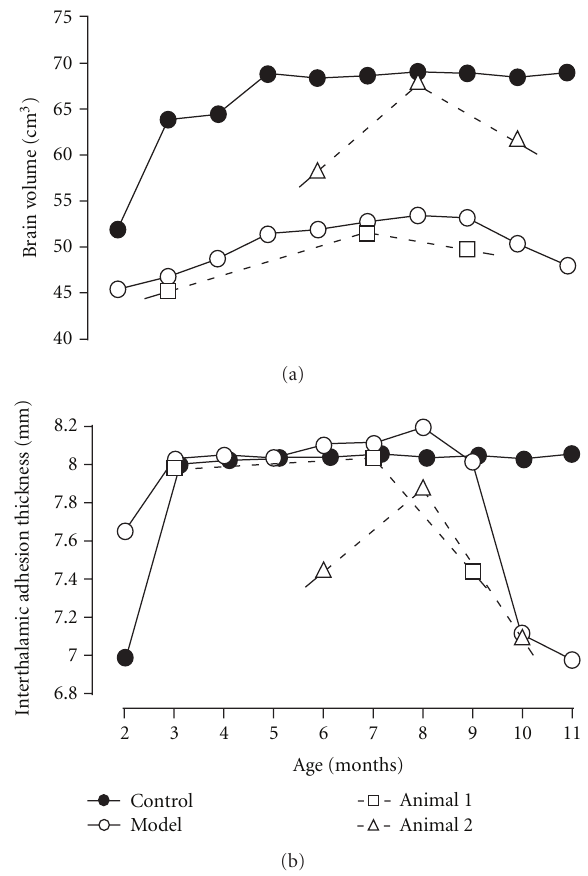
Figure 5: Changes in brain volumetry (a) and interthalamic adhesion thickness (b). Brain volume of the control dog (control) reached a steady volume at 3–5 months of age, whereas that of the a ff ected dog (model) increased gradually until 8 months and then started to decrease. Similar changes were also found in interthalamic adhesion